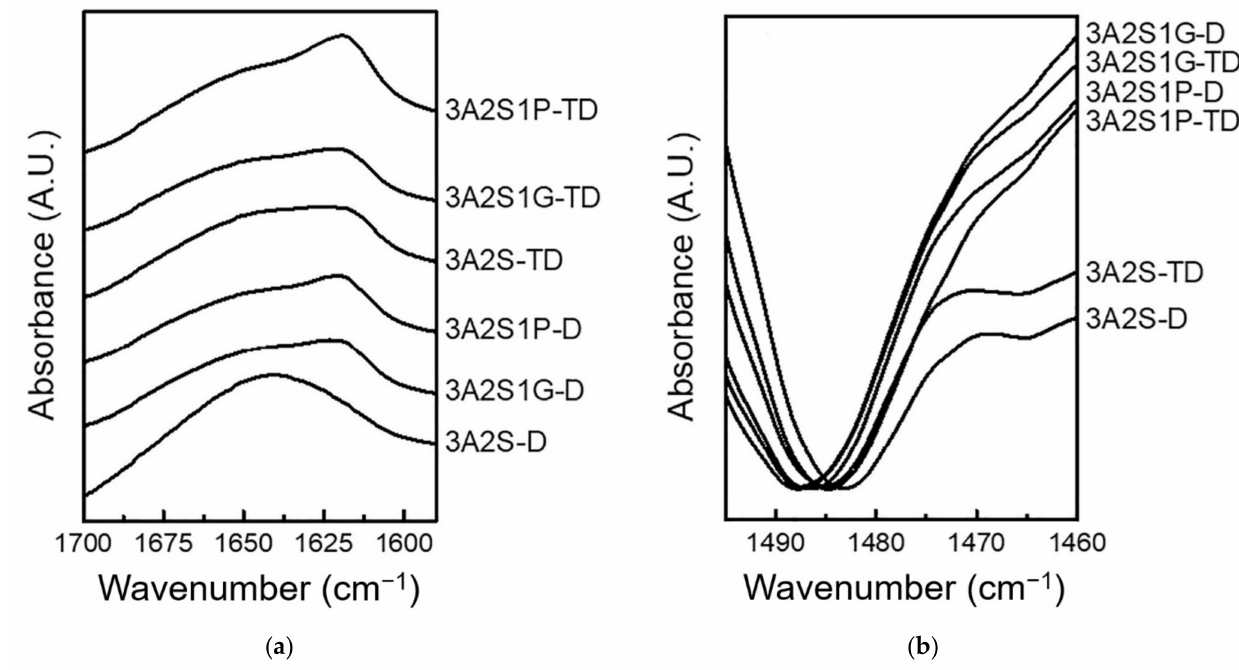
Figure 6. IR spectra of scaffolds (3A2S, 3A2S1G, 3A2S1P) that were prepared by the freeze-drying method (D) and by freeze-thawing together with the freeze-drying method (TD) in the regions of ( a ) 1700–1590 and ( b ) 1500–1460 cm − 1